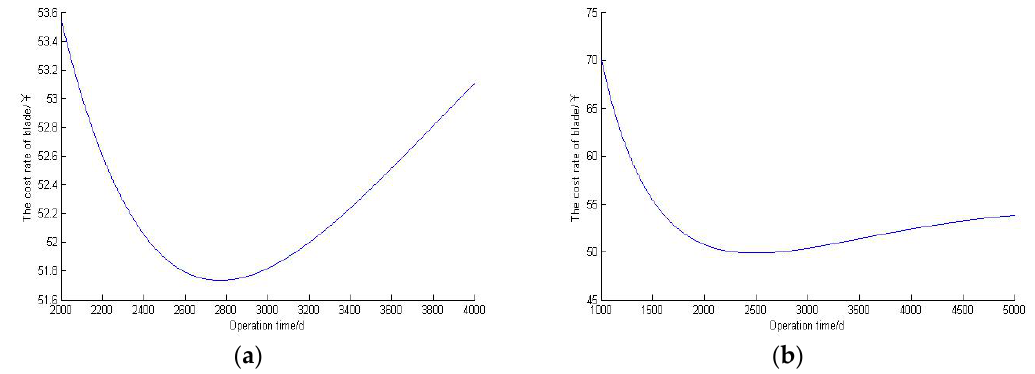
Figure 4. The cost rate of blade maintenance based on two- and three-parameter Weibull: the left-hand side ( a ) shows the blade maintenance cost rate of the two-parameter Weibull, and the right-hand side ( b ) shows the three-parameter Weibull.